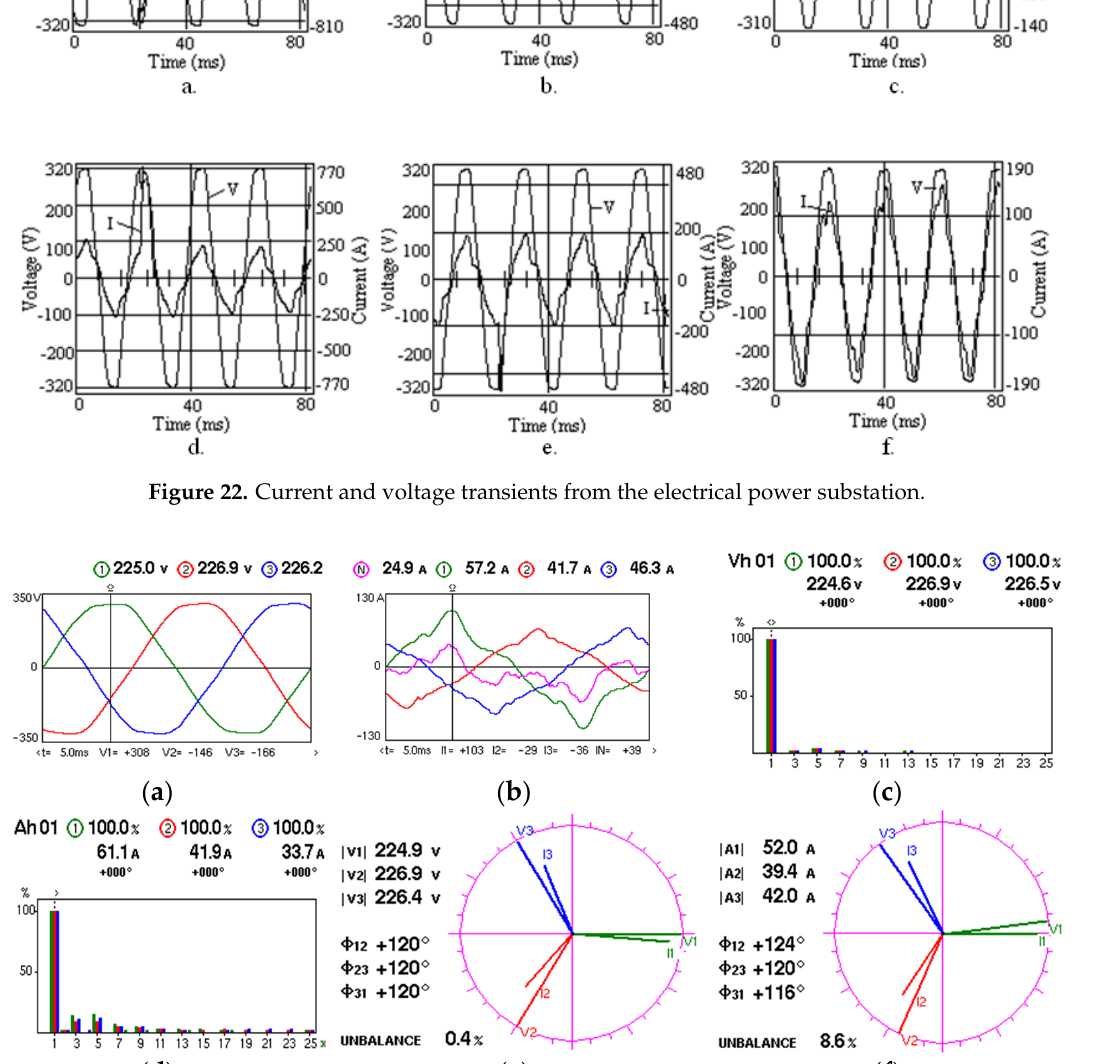
Figure 23. Instantaneous measurements of some electrical measurement from power substation of residential and educational area in a workday: ( a ) Three-phase voltages; ( b ) Three-phase currents; ( c ) Harmonic spectrum of phase voltages; ( d ) Harmonic spectrum of phase currents; ( e ) Fresnel diagram for phase voltages; ( f ) Fresnel diagram for phase currents.